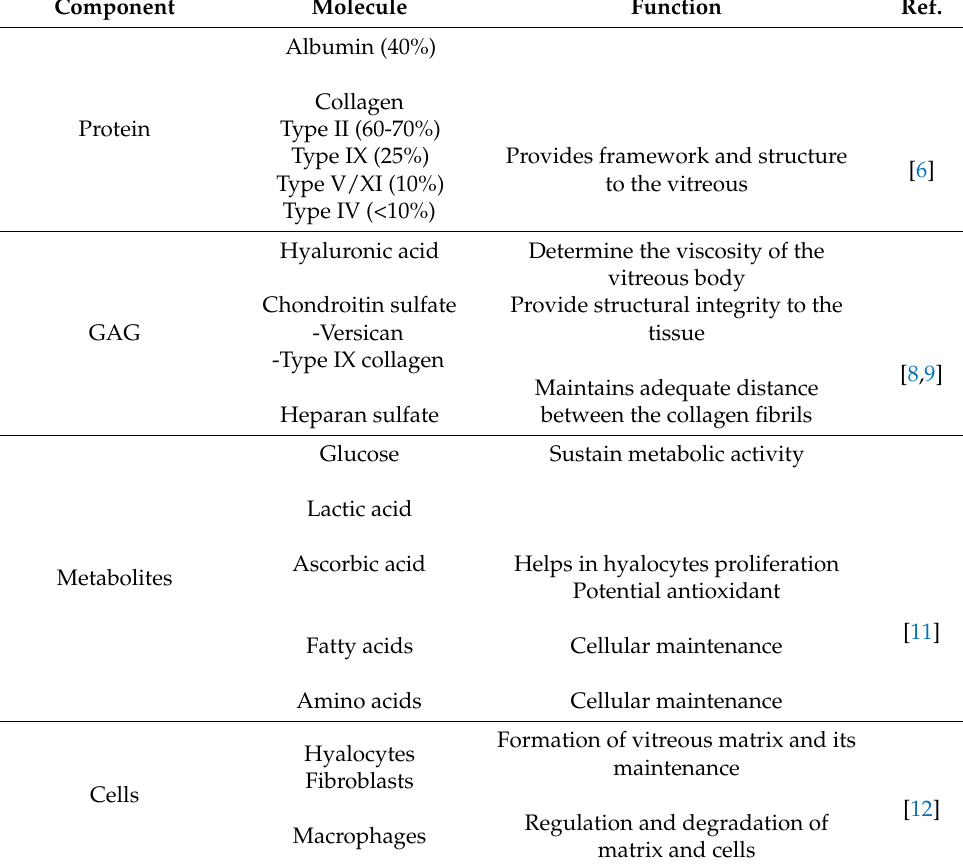
Table 1. Components in the